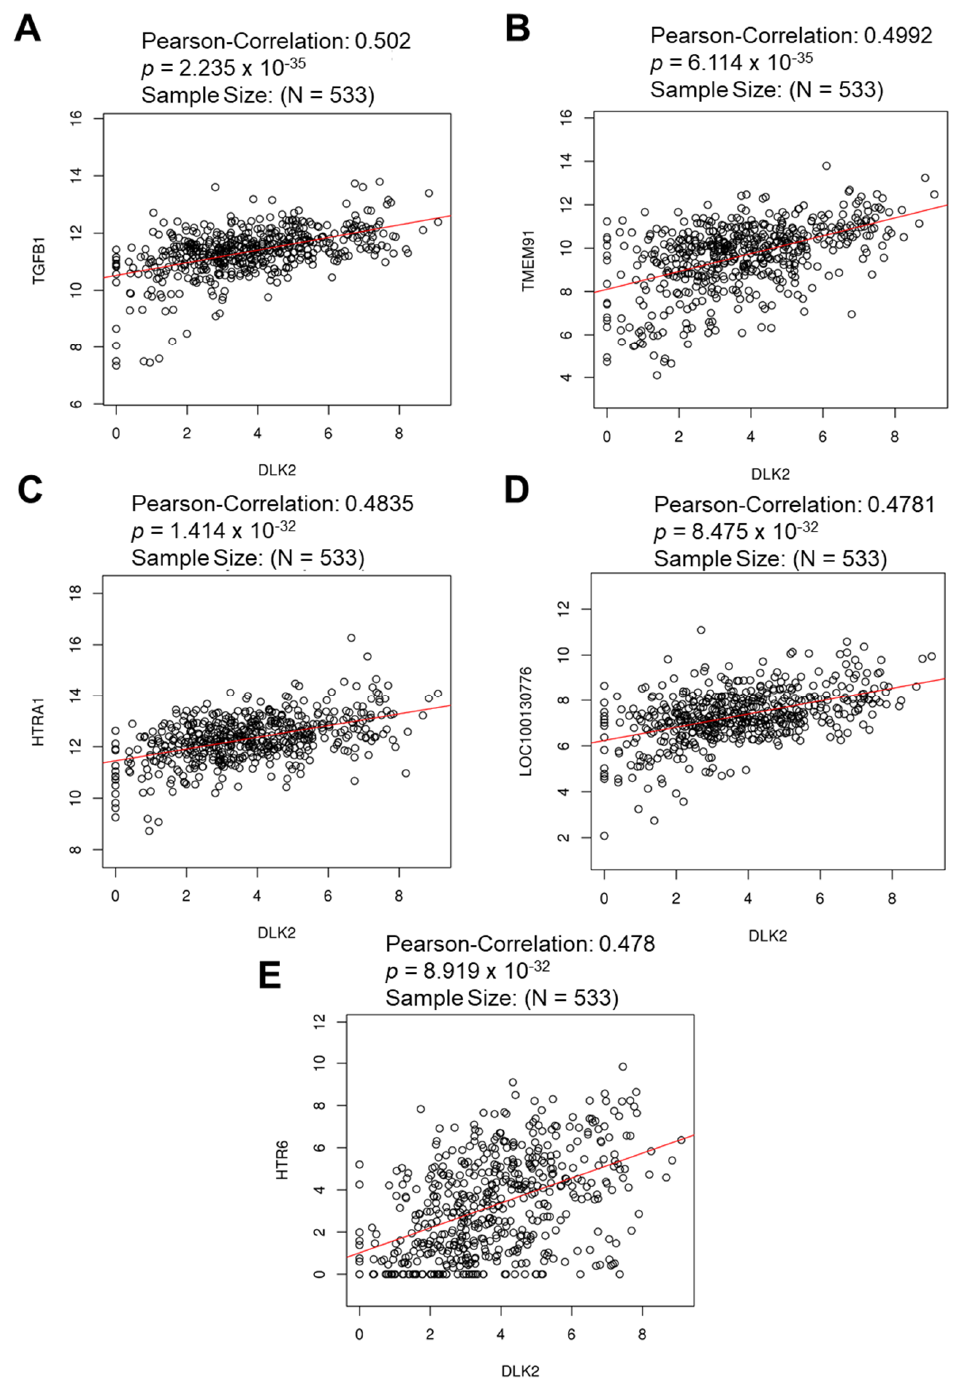
Figure 6. The top five genes positively correlated with the DLK2 level in ccRCC are identified using the LinkedOmics database. Pearson’s correlation analysis for the relationship between DLK2 level and ( A ) TGFβ1, ( B ) TMEM91, ( C ) HTRA1, ( D ) LOC100130776, and ( E ) HTR6.